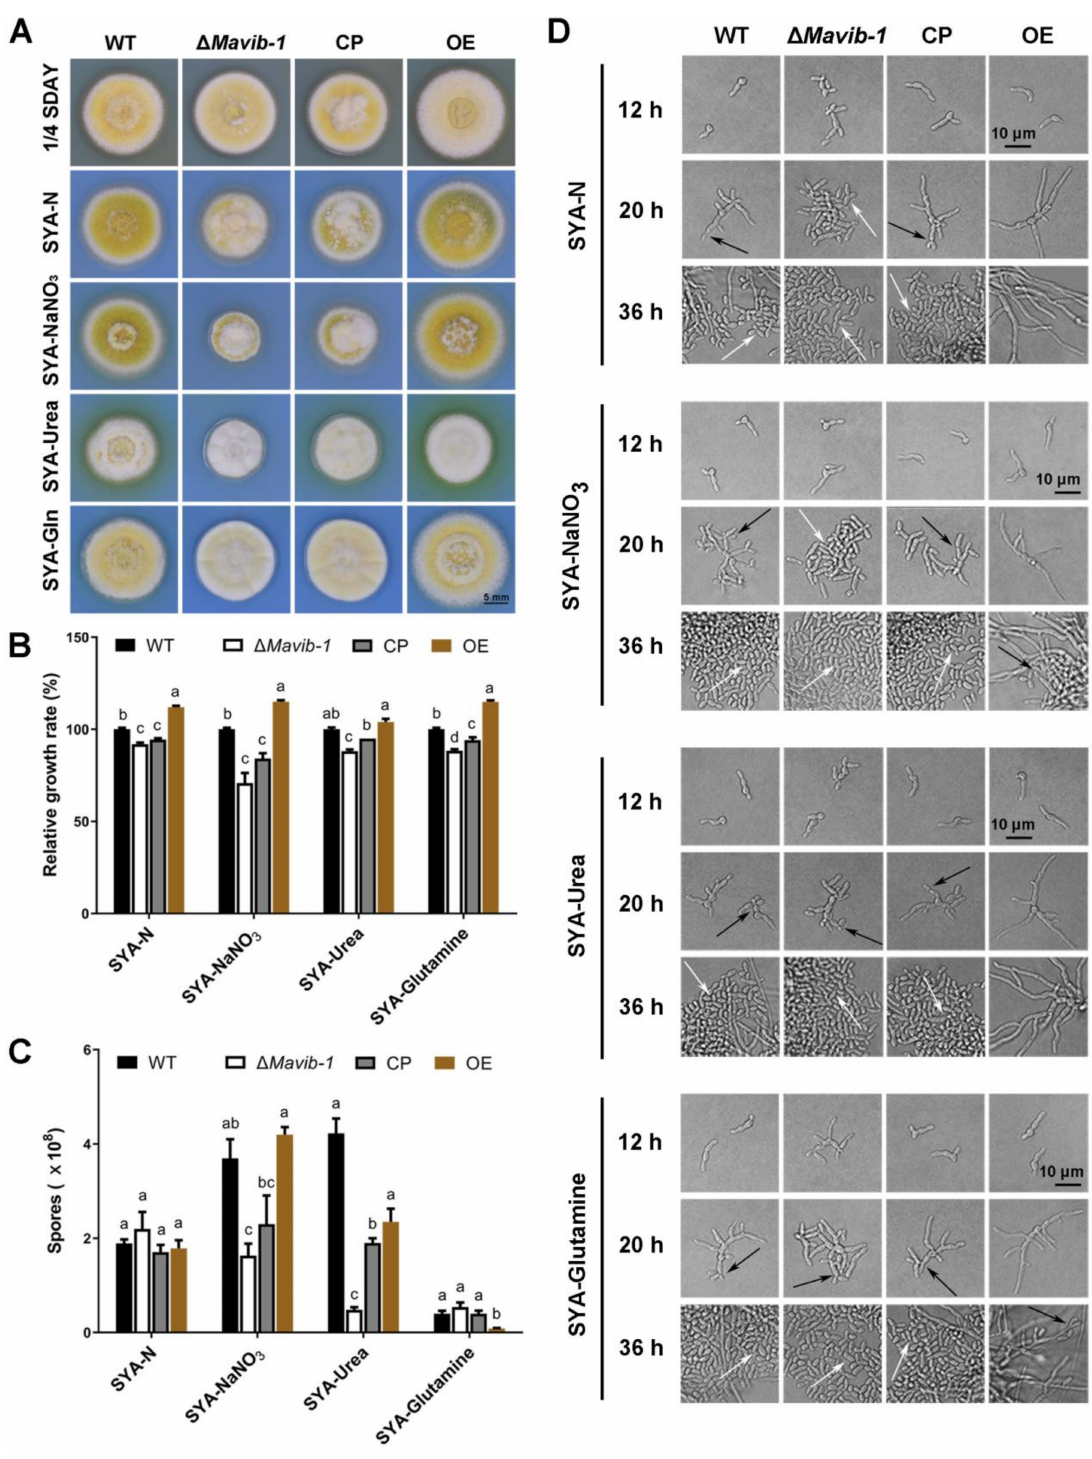
Figure 5. Colony growth and conidiation of ∆ Mavib-1 , CP and OE strains on media with different nitrogen sources. Colony morphology ( A ) and colony relative growth rate ( B ) of ∆ Mavib-1 , CP and OE strains on the media 1/4 SDAY, and SYA with different nitrogen sources. ( C ) Conidial yield of fungal strains cultured on different media for 15 d. Media contained 0.3% nitrogen source: SYA-N (SYA without NaNO 3 ), urea (difficult to use), NaNO 3 (middle), Gln (easy to use). Each trial was repeated three times for statistical analysis. Different lower-case letters mean significant difference at p < 0.05. ( D ) Conidiation of ∆ Mavib-1 , CP and OE strains on different media. The black arrows indicate NC, and the white arrows indicate